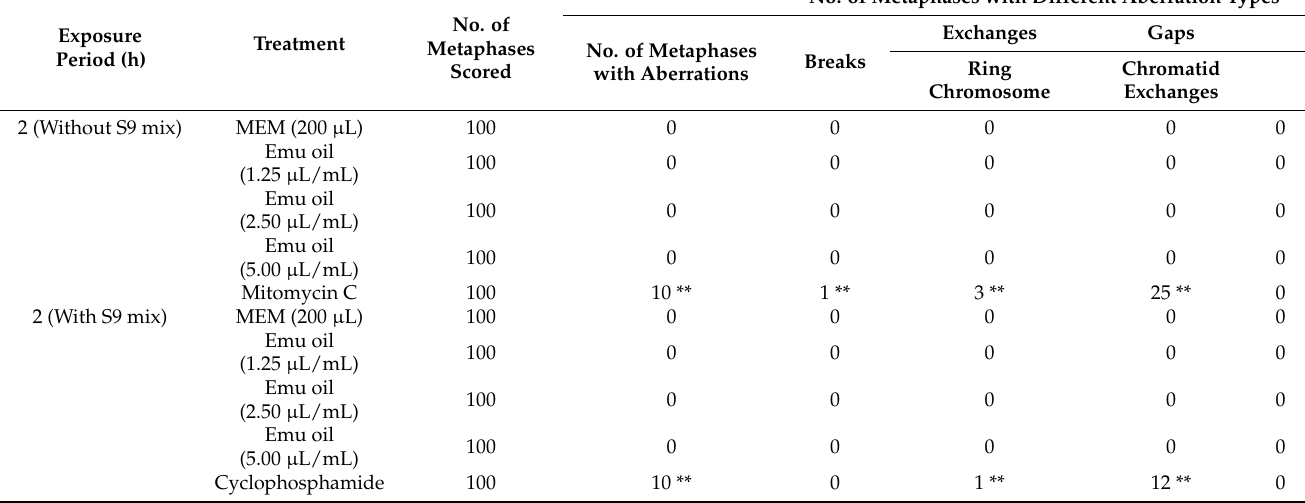
Table 4. Summary results of chromosome aberration assay in Chinese hamster lung (CHL) cells treated with emu oil.